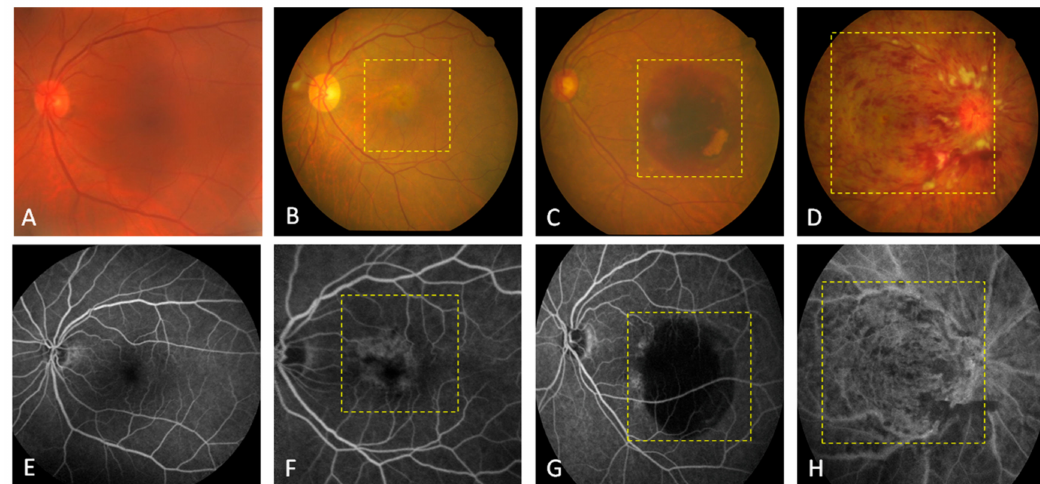
Figure 1. Fundoscopic and fluorescein angiographic examinations of the patients with retinal diseases. Clinical features of the ( A – D ) fundus and ( E – H ) central retina are presented in the photographs. The fundus photos and fluorescein angiographic (FAG) images showed normal blood flow in a patient with cataracts ( A , E ), depigmentation in a patient with wet age-related macular degeneration (AMD; B , F ), a light red patch in a patient with polypoidal choroidal vasculopathy (PCV; C , G ), and diffuse hemorrhage in a patient with central retinal vein occlusion (CRVO; D , H ) in the yellow dashed line boxes.